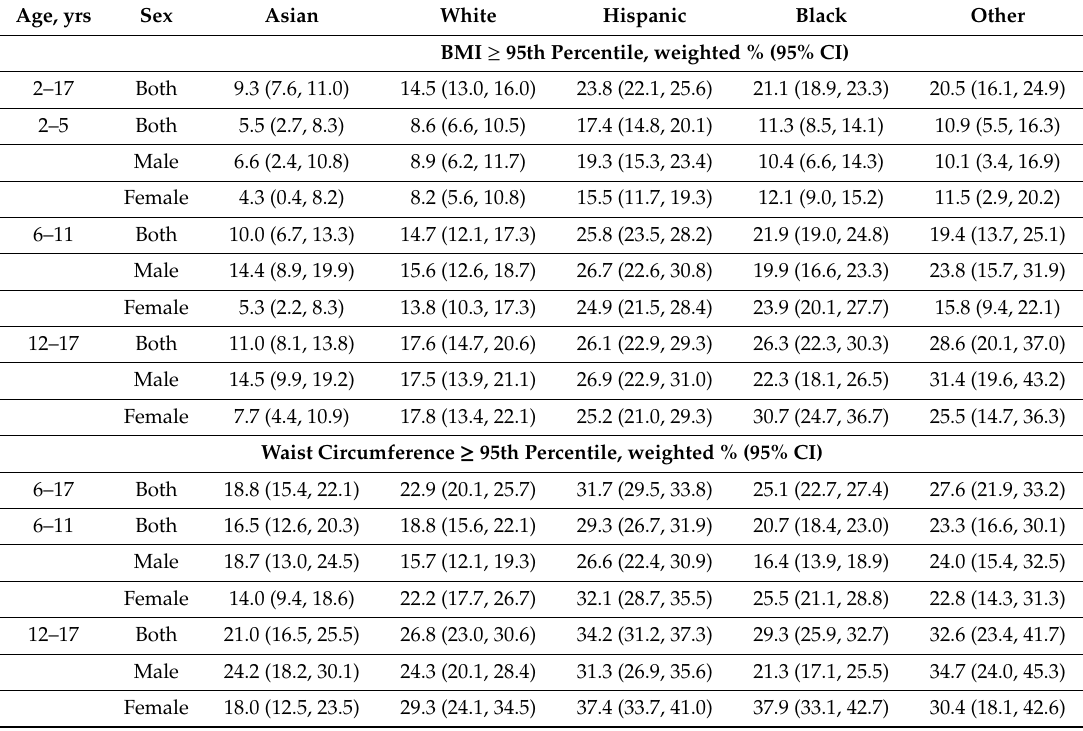
Table 2. Obesity, central obesity, elevated FMI, and low LBMI by race /